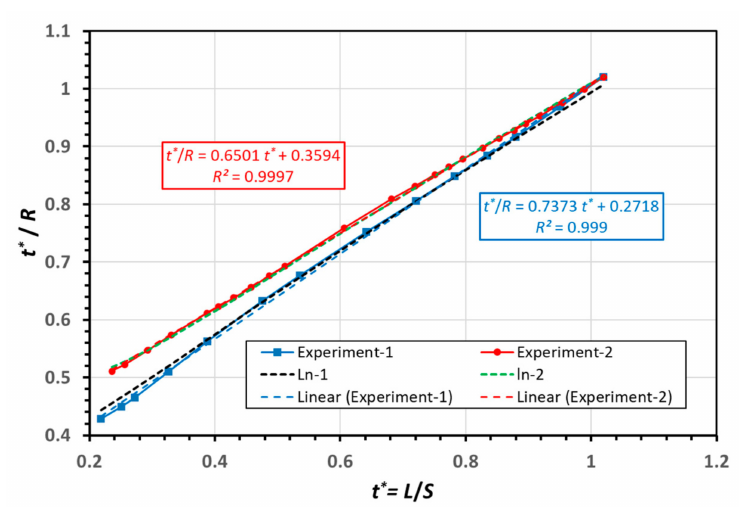
Figure 12. The normalized t ∗ / R tail, with t ∗ the normalized time (i.e., t ∗ = L / S ), R the normalized ore recovery (i.e., R ( t ∗ ) = M Rec ( t ∗ ) / M Rec ), fits perfectly to a linear model showing that the kinetics is governed by an Azuara model (solute